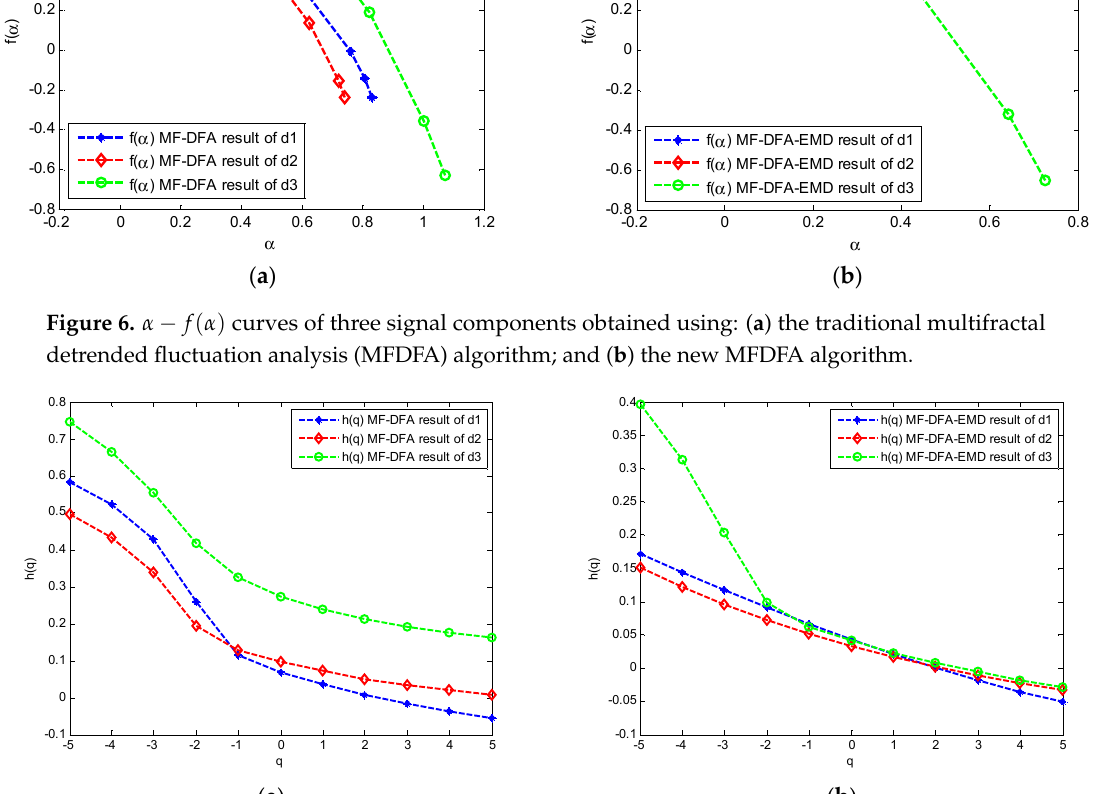
( b ) Figure 9. Double-log relation graph of low-frequency component d1 obtained using: ( a ) the traditional MFDFA algorithm; and ( b ) the new MFDFA algorithm. . ( b ) Figure 10. Double-log relation graph of low-frequency component d2 obtained using: ( a ) the traditional MFDFA algorithm; and ( b ) the new MFDFA algorithm.